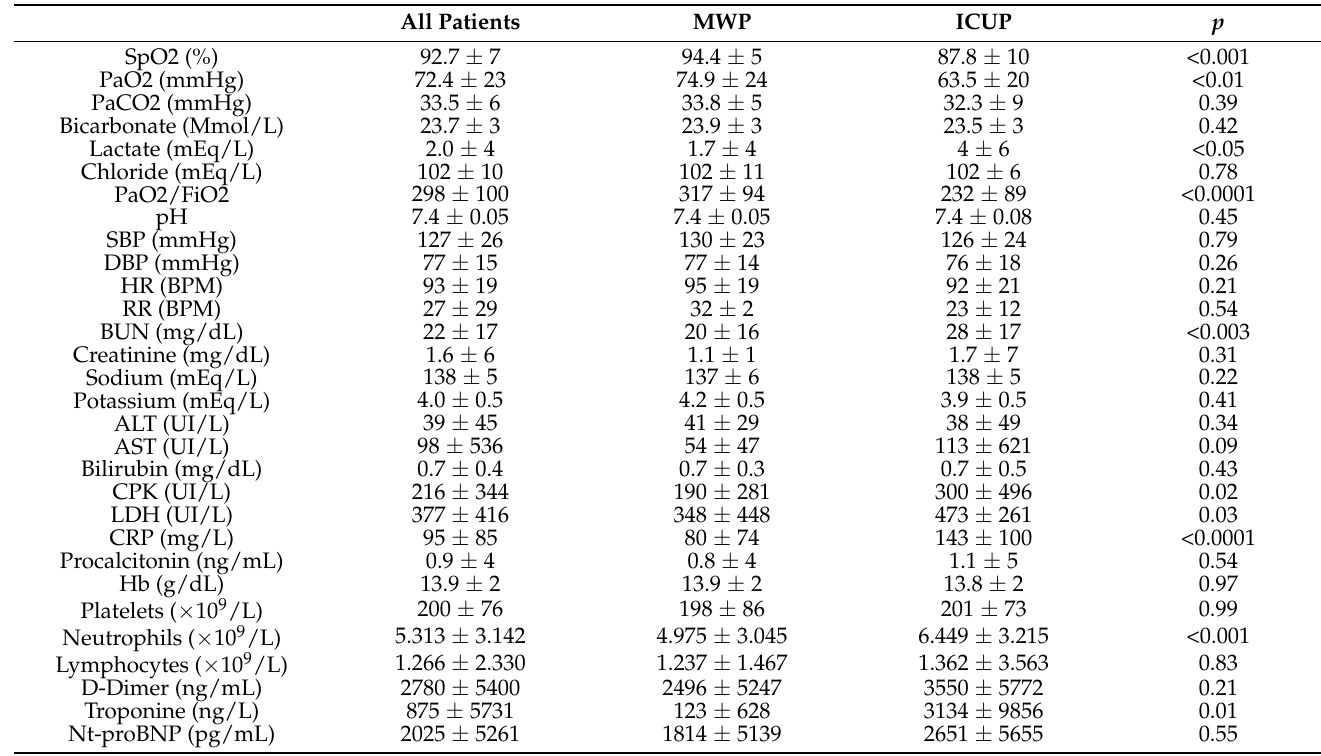
Table 2. Comparison of vital signs, arterial blood gas analysis, and the laboratory findings between groups. All